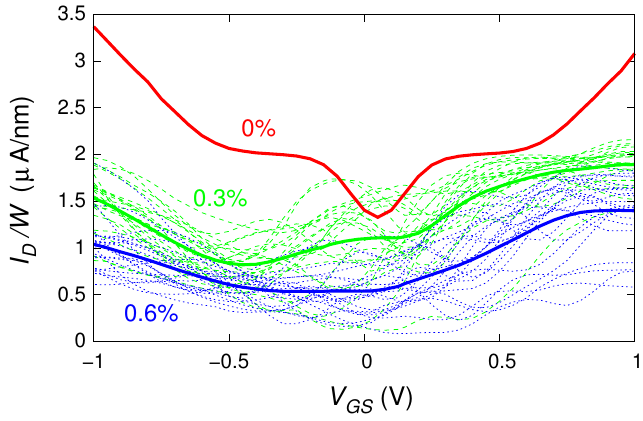
Figure 2. Transfer characteristics (obtained for V DS = 0.1 V) of the double-gate field-effect-transistor based on a 20-nm-long graphene ribbon with a boron concentration of 0% (undoped ribbon), 0.3%, and 0.6%. The thin lines (dashed for the 0.3% boron concentration, dotted for the 0.6% boron concentration) show the results for 23 individual realizations of the dopant distribution, while the thick lines represent the average over the ensemble. The current value was divided by the ribbon width W = 3.81 nm in order to represent the current